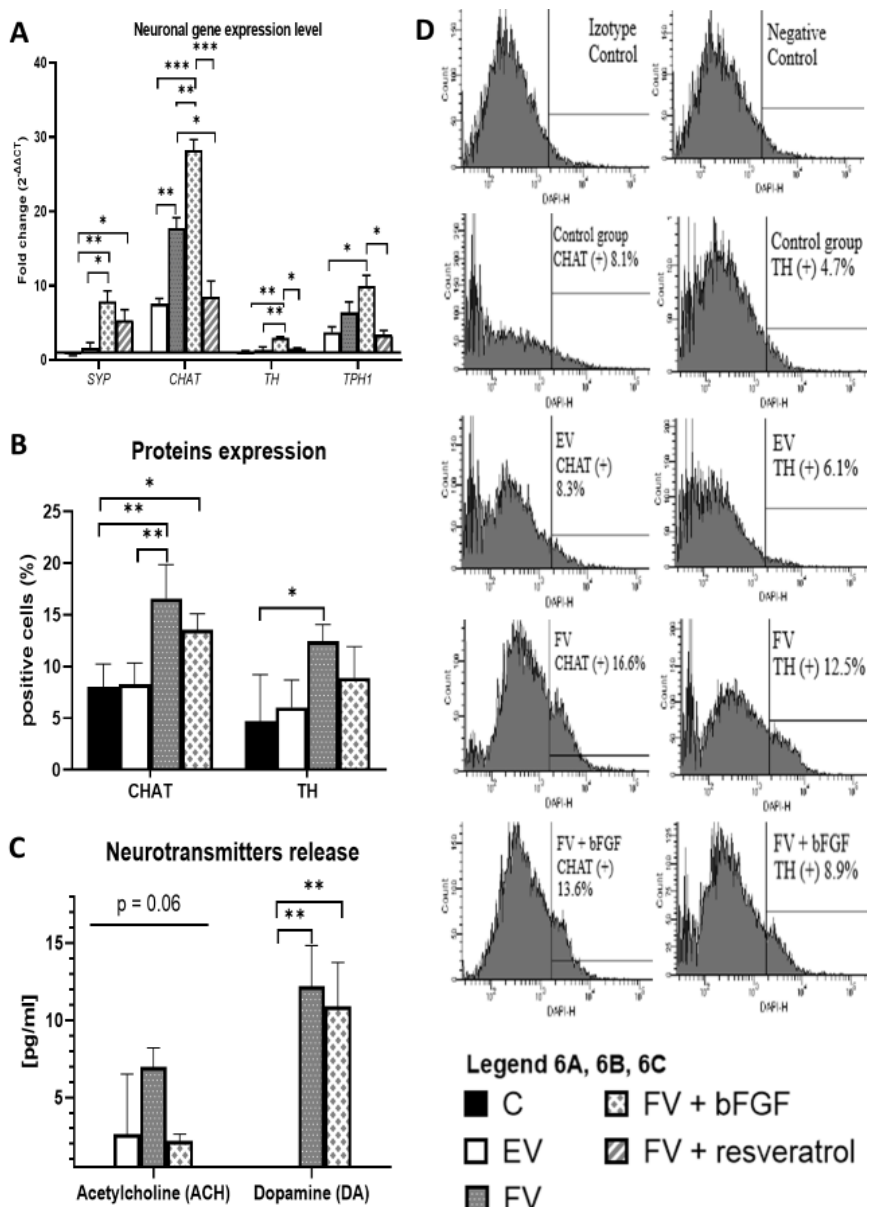
Figure 5. Overview of the methods for seeding, transducing, and differentiation.